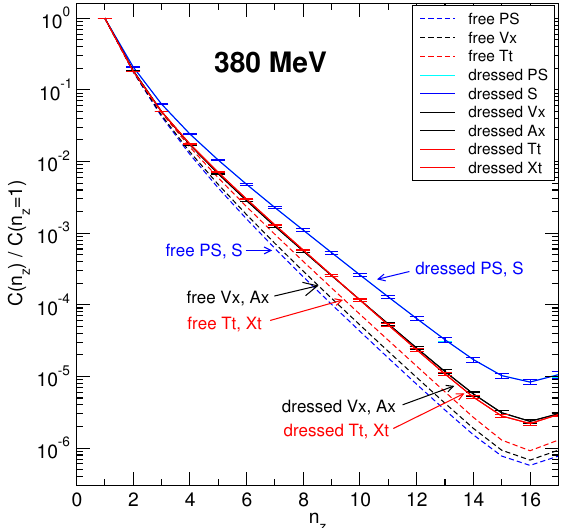
Figure 5. E 1 and E 2 multiplets in Equations (30) and (31) for interacting ( dressed ) and non-interacting ( free ) calculations at T = 380 MeV. The figure is from Ref.